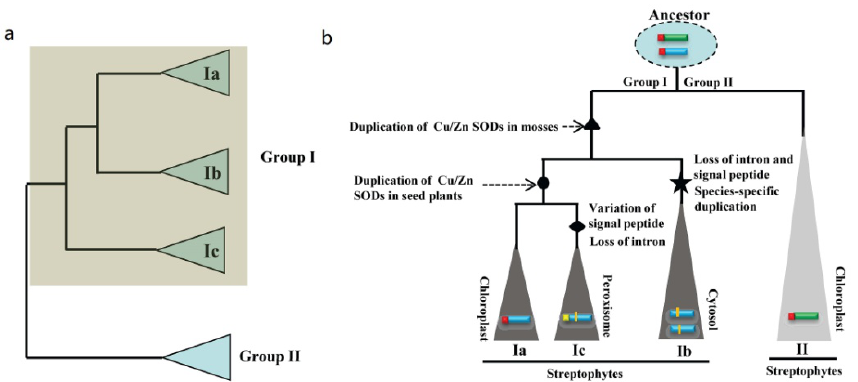
Figure 8. Evolutionary history and duplication timing of the Cu/Zn SOD gene family in plant species as proposed. ( a ) Tree summarizing our current understanding of the phylogenetic relationships based on our analyses. Two groups (group I and group II) were identified. ( b ) Evolutionary scenario Ia, Ib, Ic, and II lineages.